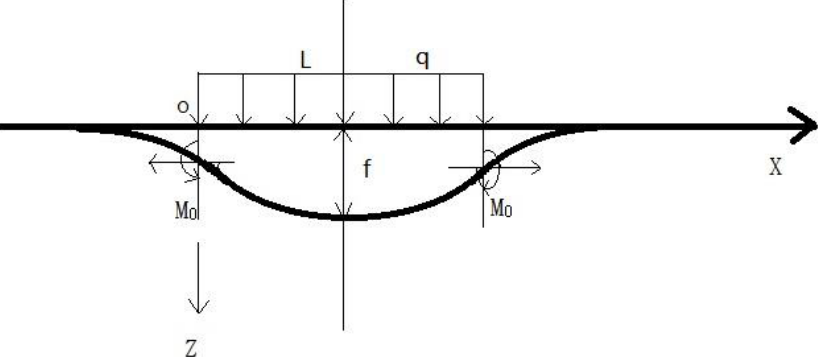
Figure 1. Lateral landslide pipe force diagram.